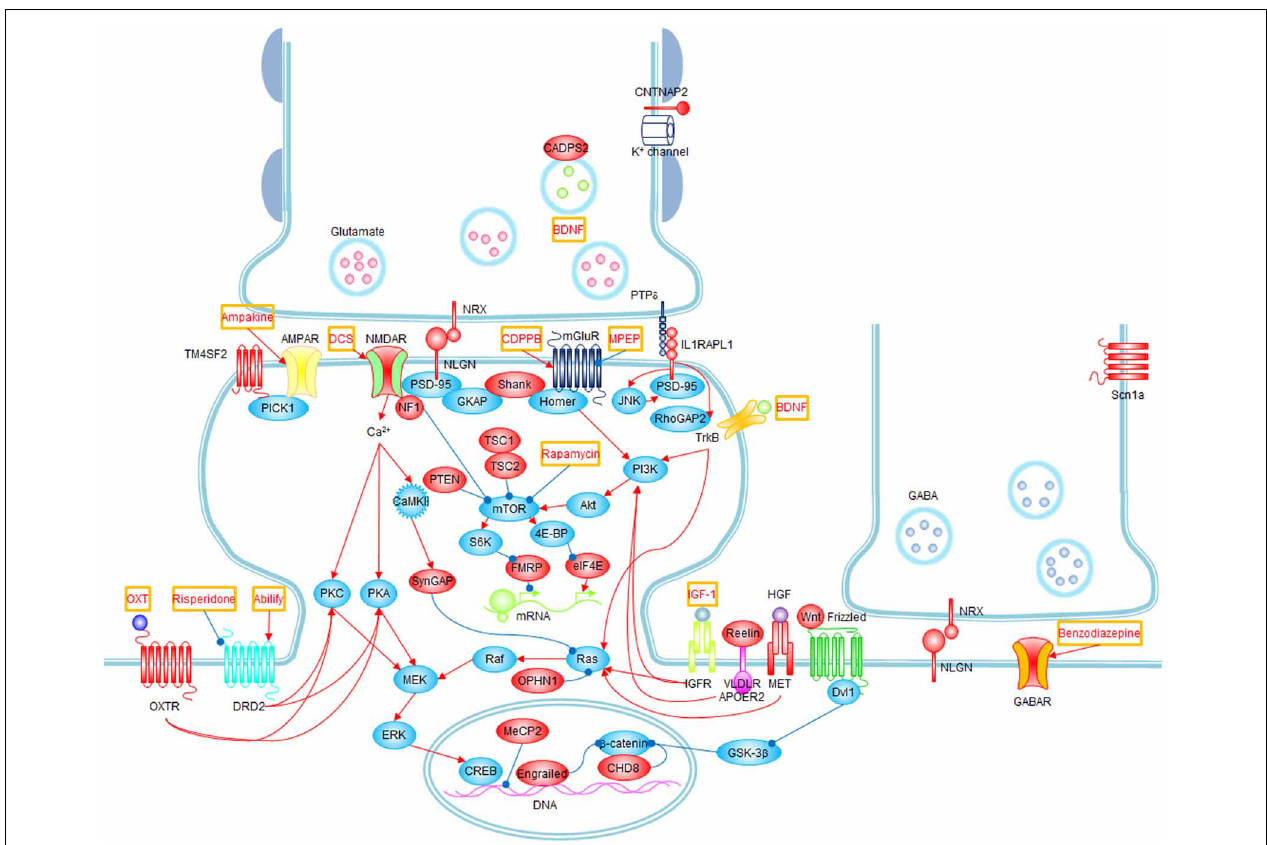
FIGURE 1 | Signaling pathways and possible treatments associated with ASD. Molecules whose mutations or polymorphisms are associated with ASD are indicated in red. Stimulations and inhibitions are indicated by red and